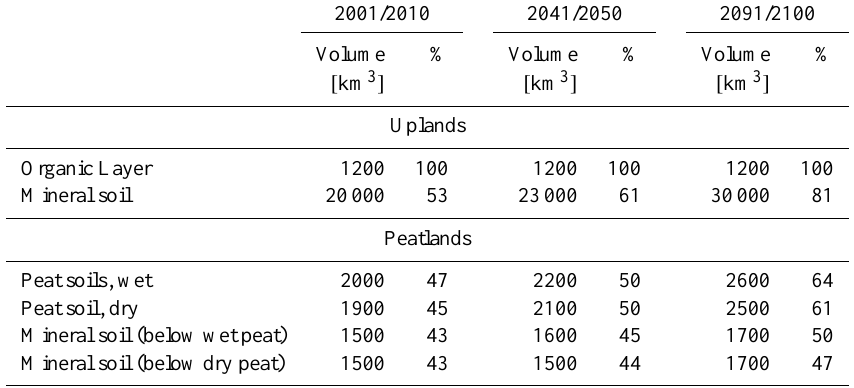
Table 5. Volumes of thawed mineral and peat soil for different time slices and percentages of total soil volume (2 significant